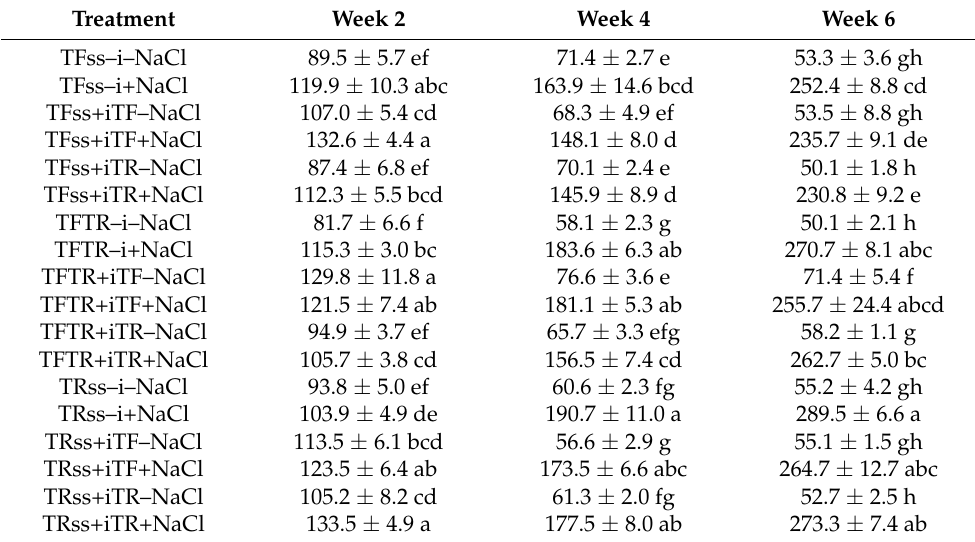
Table 2. Changes of substrate electrical conductivity (EC, mS m − 1 ) during the